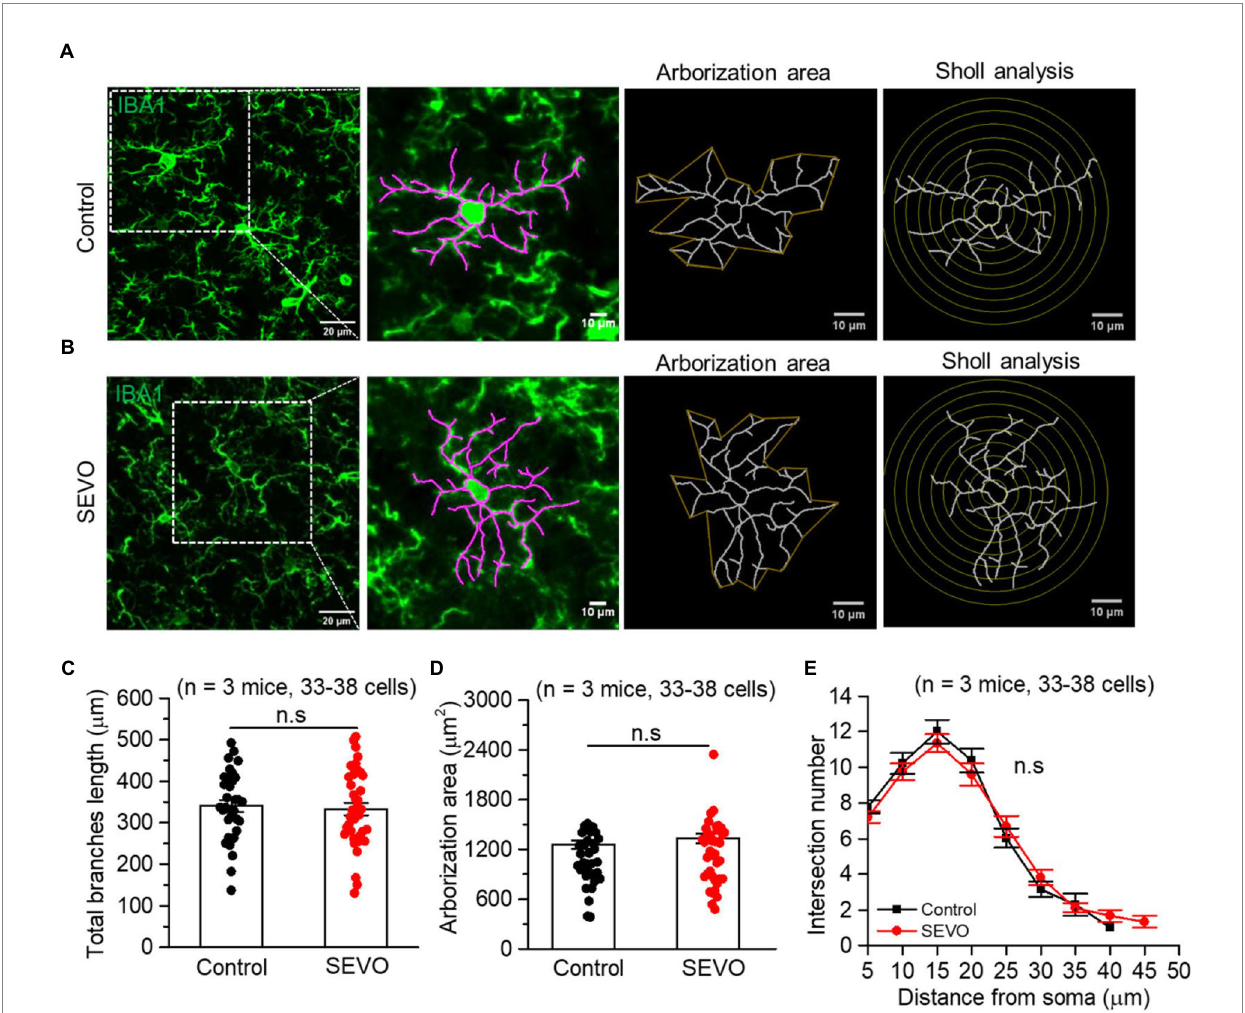
FIGURE 1 Two-dimensional morphology of microglia 7 days after prolonged neonatal sevoflurane exposure. (A,B) Representative images of IBA1-labeled microglia in the control group and SEVO group 7 days after prolonged neonatal sevoflurane exposure. (C) Quantification of the total length of microglia branches 7 days after prolonged neonatal sevoflurane exposure ( p = 0.728, two-sample t- test). (D) Quantification of the arborization area of microglia 7 days after prolonged neonatal sevoflurane exposure ( p = 0.313, two-sample t- test). (E) Sholl analysis of microglial morphology 7 days after prolonged neonatal sevoflurane exposure ( p = 0.906, two-sample t- test). Data are shown as mean ± SEM.